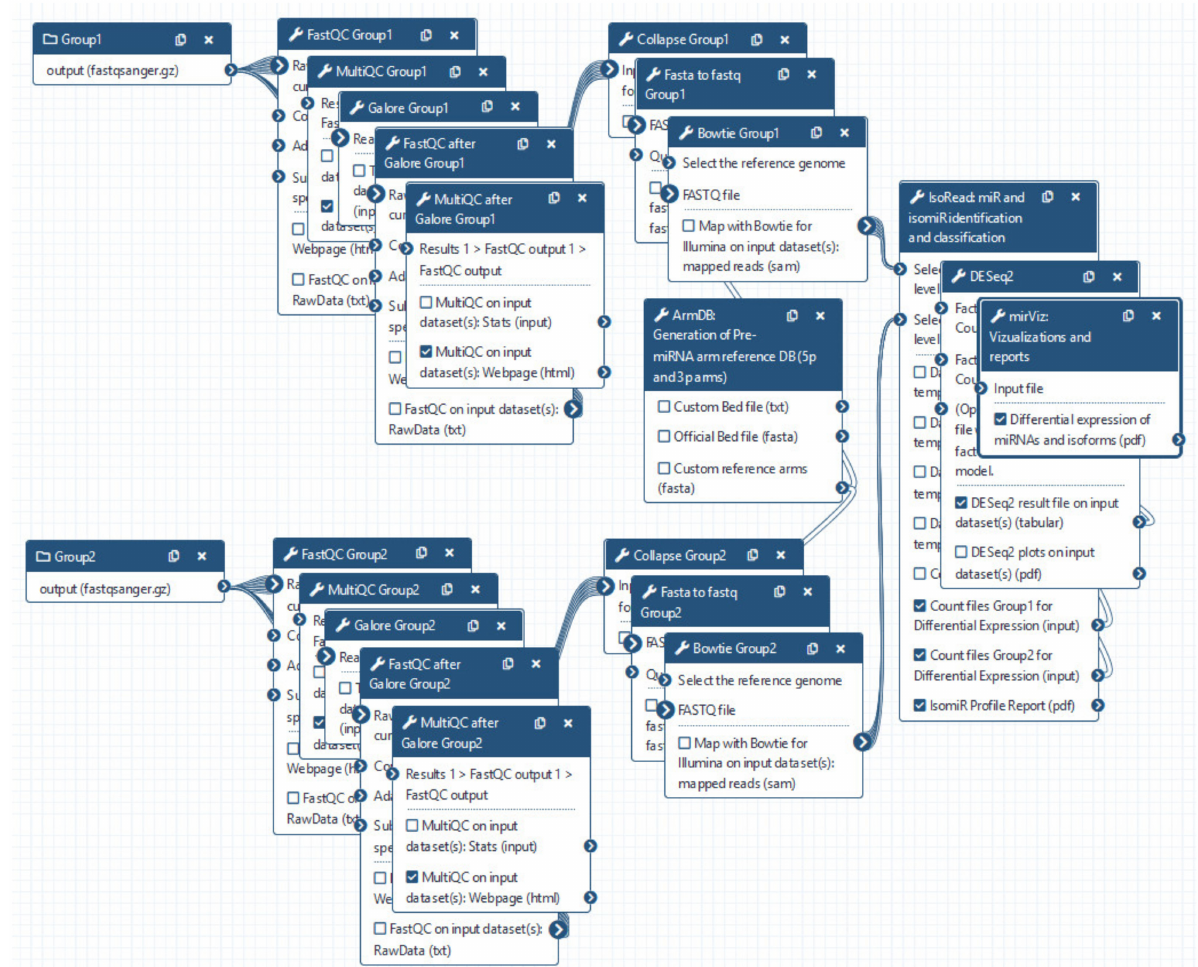
Figure 5. miRGalaxy workflow. User is asked to upload FASTQ files and run the workflow (default options are preset for every step of the analysis and can be changed upon user